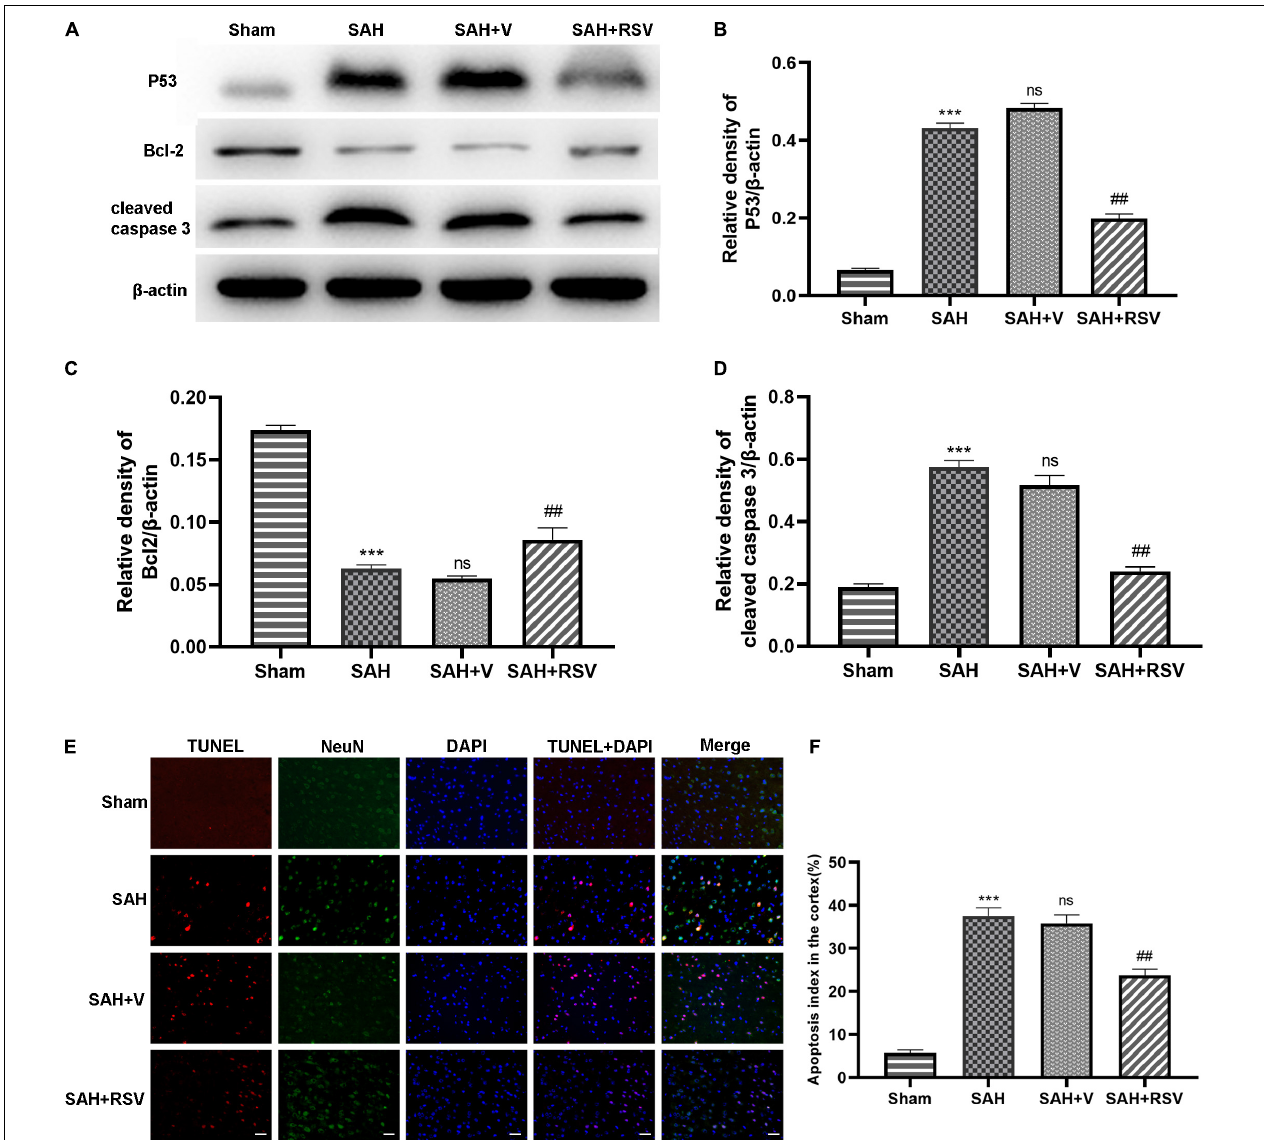
FIGURE 2 | Effect of RSV on neuronal apoptosis was evaluated 24 h after SAH. (A) Western blot showed pro- and antiapoptotic proteins in the temporal cortex. (B–D) Expression of P53, Bcl-2, and cleaved caspase 3 protein levels were standardized to the level of β -actin. (E) Representative immunofluorescence images showed that RSV treatment significantly attenuated neuronal apoptosis in the temporal cortex 24 h after SAH. (F) The apoptosis index was represented by the percentage of TUNEL-positive cells against neuronal cells. The number of TUNEL-positive neurons was ameliorated by RSV treatment following SAH. Data were presented as mean ± SEM ( n = 6). Bar = 50 µ m. *** p < 0.001 vs. sham group; ns p > 0.05 vs. group with SAH; ## p < 0.01 vs. vehicle-treated